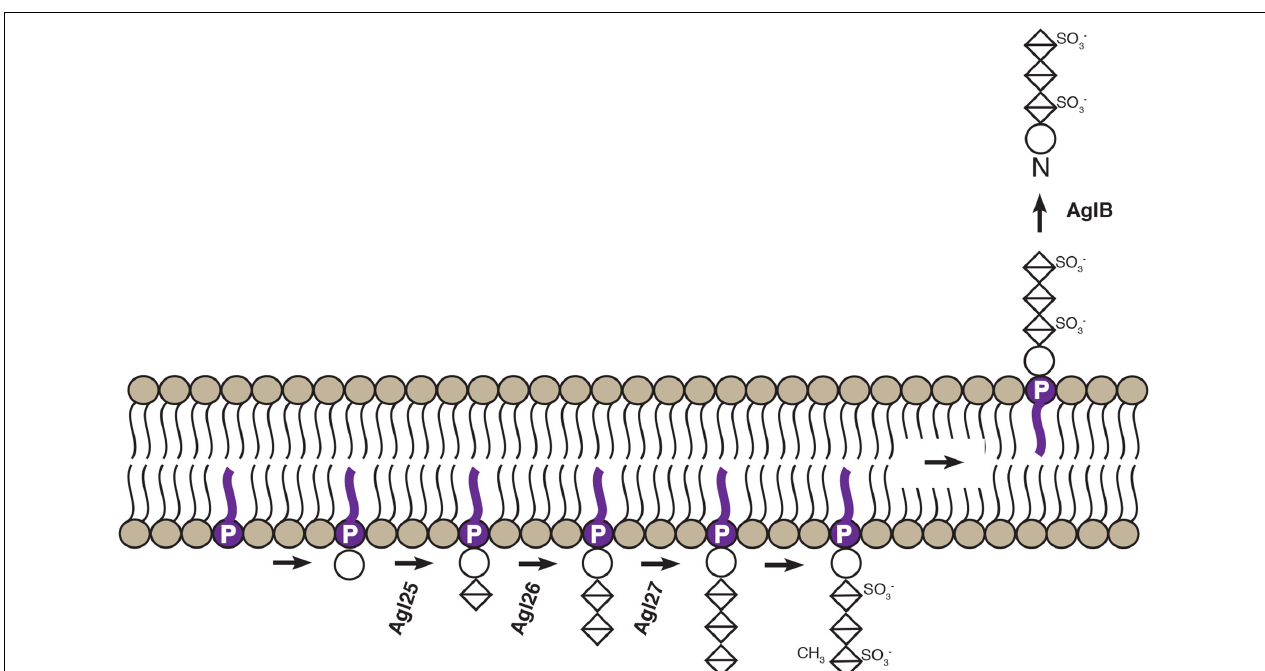
FIGURE 6 | Schematic depiction of confirmed steps of an Hbt. salinarum N-glycosylation pathway. Based on the findings reported here and previously (Zaretsky et al., 2019; Vershinin et al., 2021), experimentally confirmed steps of the Hbt. salinarum pathway responsible for assembling and transfer of an N-linked tetrasaccharide are presented. DolP is shown in purple. Circles correspond to hexoses and crossed diamonds corresponds to hexuronic